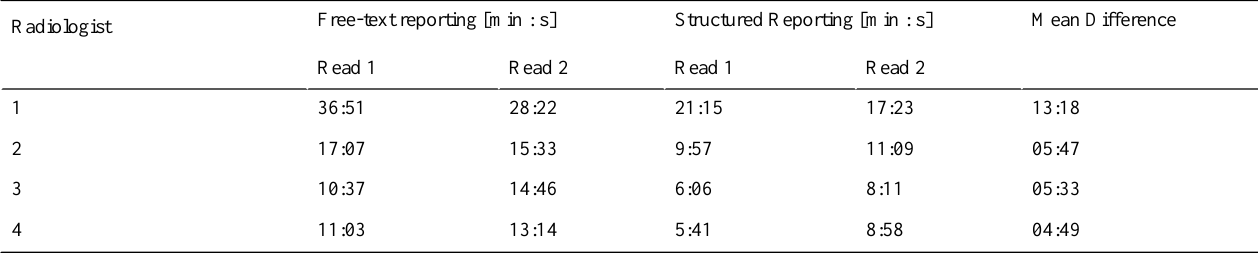
Table 2. The time utilized for structured reporting and free-text